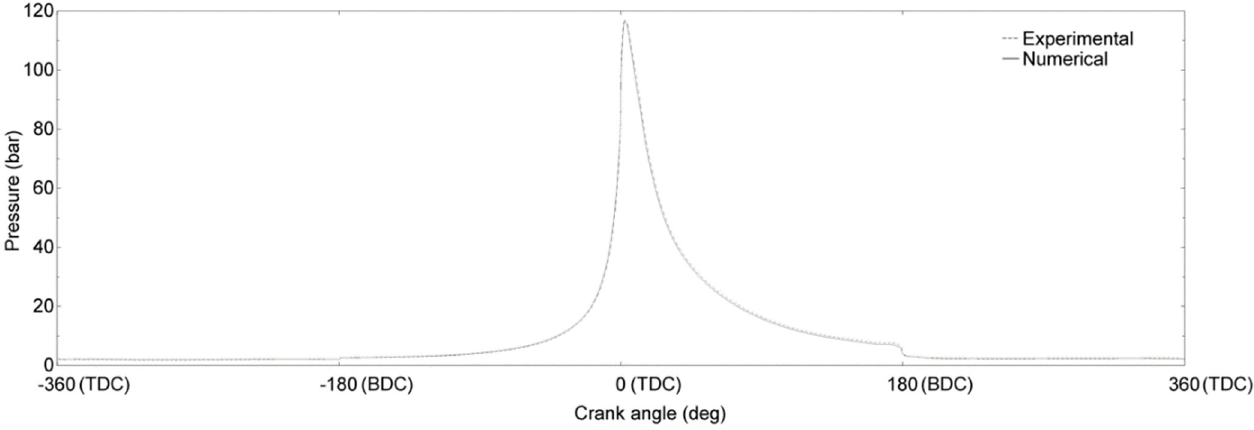
Figure 2. In-cylinder pressure.